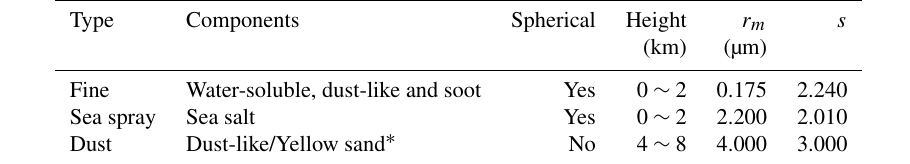
Table 1. Aerosol modes used in this study. Type Components Spherical Fine Water-soluble, dust-like and soot Sea spray